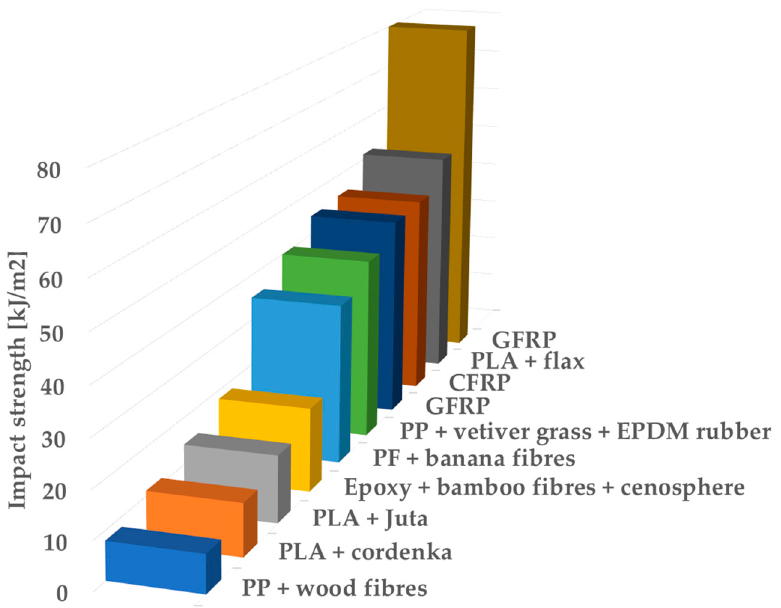
Figure 10. Impact strength of bio-based and traditional composites. Data from Refs. [84-91] 5. Wood